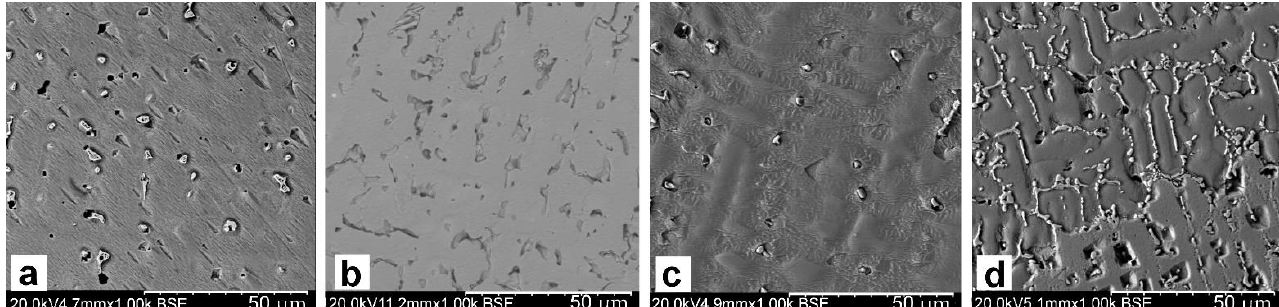
Figure 5. The SEM image of the alloy surface, metal mould: ( a ) CuSn8; ( b ) CuSn8Ti2; ( c ) CuSn8Ni3; ( d ) CuSn8Ni3Ti2.